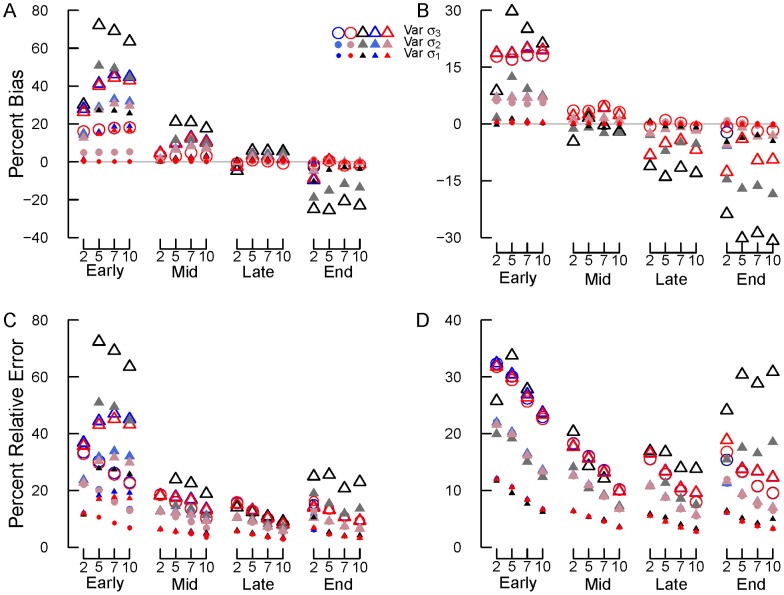
Results for simulations with variable normal errors (option 1).Percent bias using (A) SV and (B) REP transformations and relative error using (C) SV and (D) REP transformations. Early, mid, late and end are early, mid, late and end stage decomposition simulations. The numbers 2, 5, 7 and 10 are the numbers of measurements used in each simulation. Blue circles = NLS, Red circles = Normal ML, gray/black circles = Beta ML. In most cases, nls = Normal ML so that the red circles cover the blue circles. Gray lines in panels (A) and (B) show 0% bias.